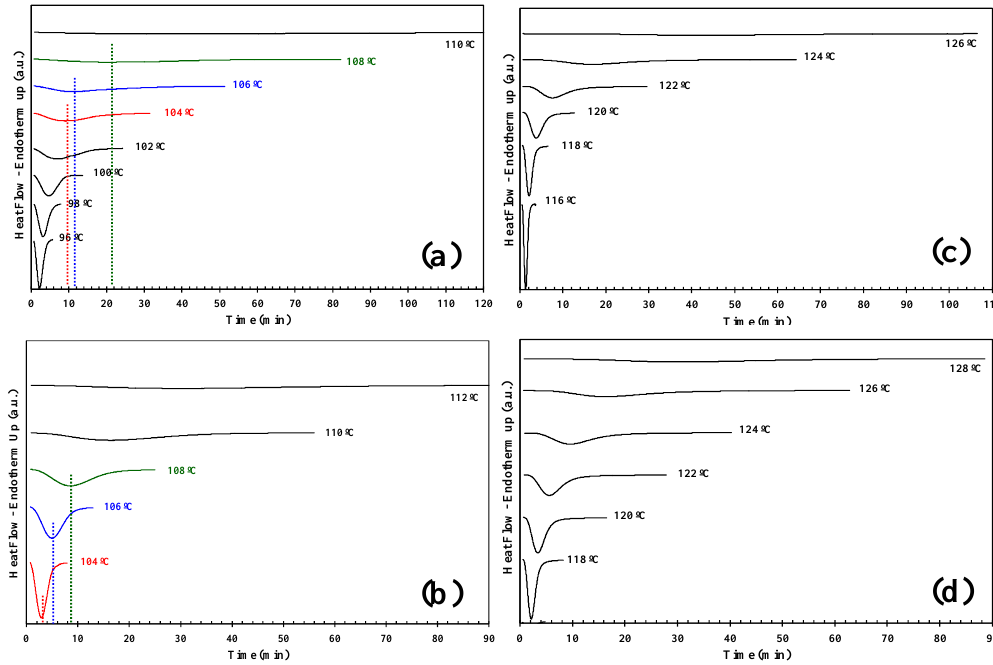
Figure 1. Differential scanning calorimetry (DSC) thermograms of isothermal crystallization of ( a ) PHBV; ( b ) poly(3-hydroxybutyrate- co -3-hydroxyvalerate)/ tungsten disulfide inorganic nanotubes (PHBV/INT-WS 2 ) (0.1 wt %); ( c ) PHBV/INT-WS 2 (0.5 wt %) and ( d ) PHBV/INT-WS 2 (1.0 wt %) obtained at the indicated crystallization temperatures.